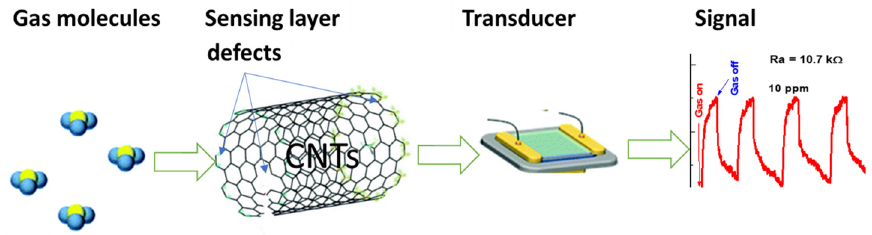
Figure 16. Sensing mechanism of defect-induced carbon nanotubes.